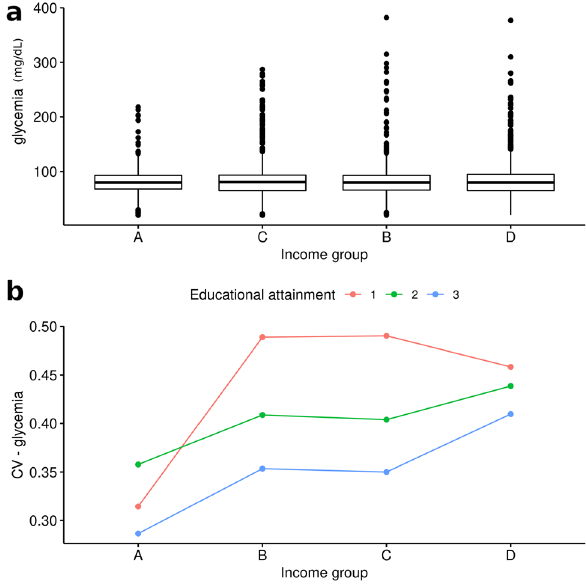
Figure 5. Fasting glycemia and Coefficients of Variation by income group. Above: boxplots for values of glycemia (mg/dL) for the four income groups. Below: Coefficients of Variation for glycemia for the four income groups and the three levels of educational attainment.